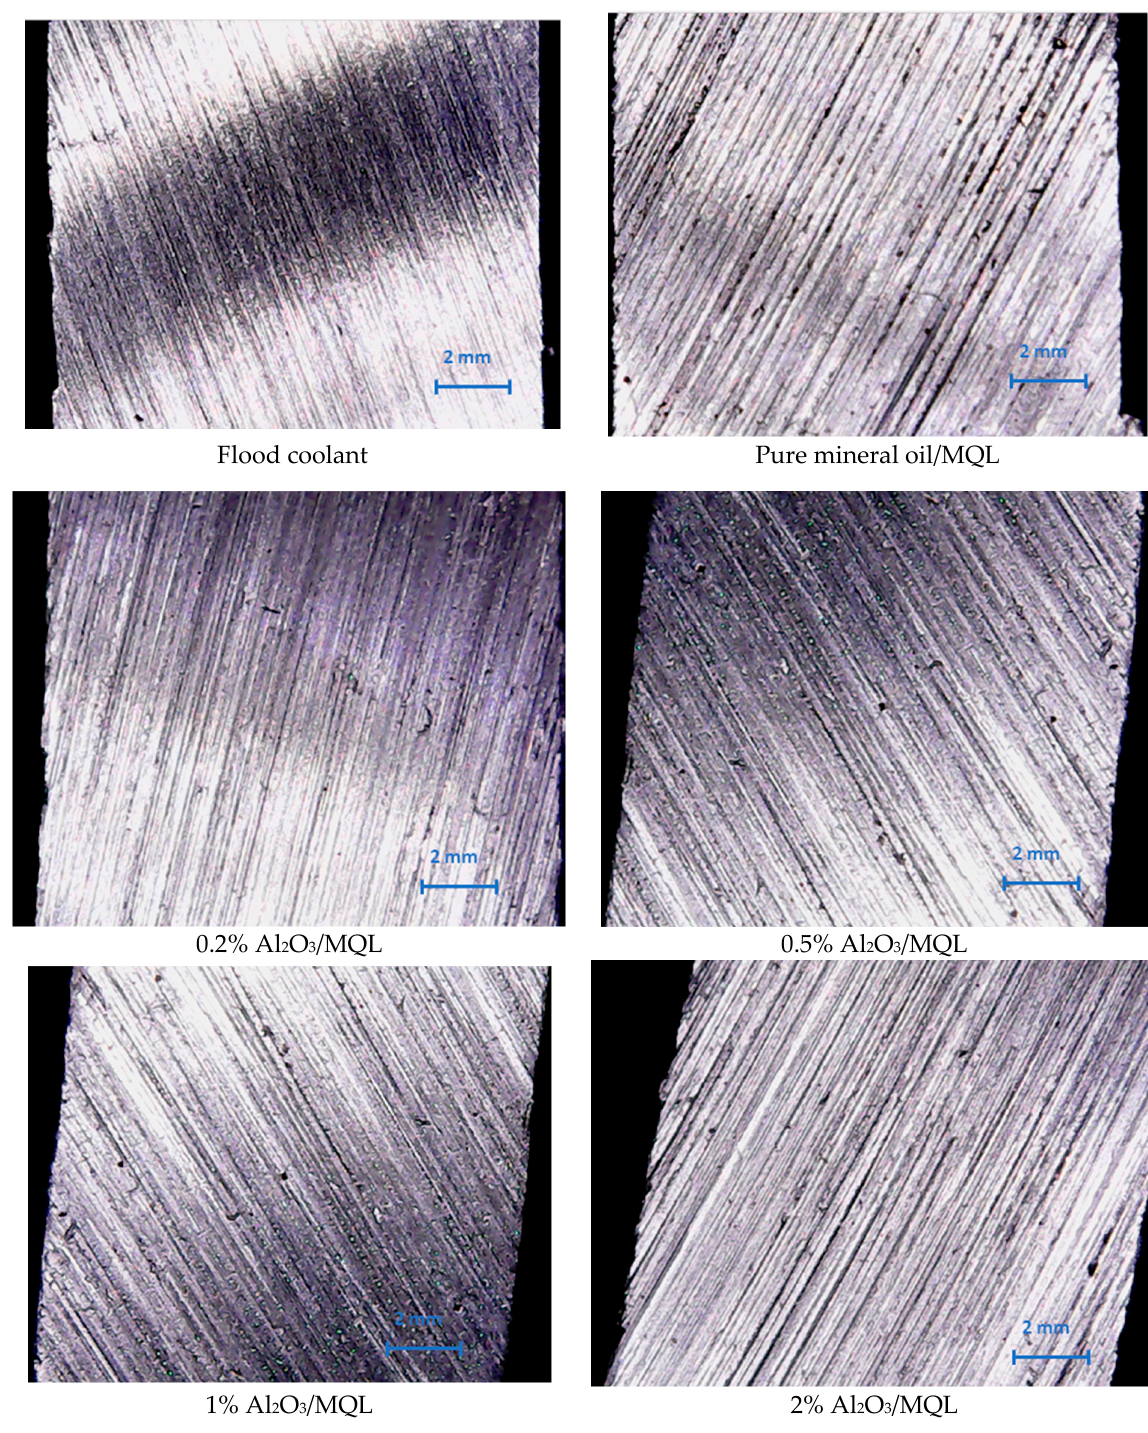
Figure 3. Surface micromorphology under different lubricant types .